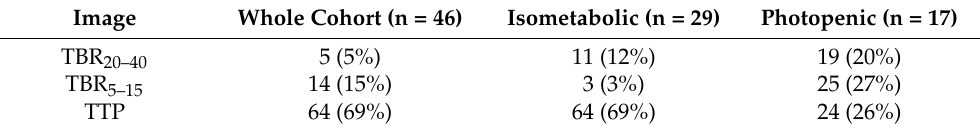
Table 1. Number of significant features ( p < 0.05) according to Wilcoxon test for paired non-parametric variables. The total number of included features per image was 93 (pyradiomics default excluding shape features). Numbers are provided as absolute values and